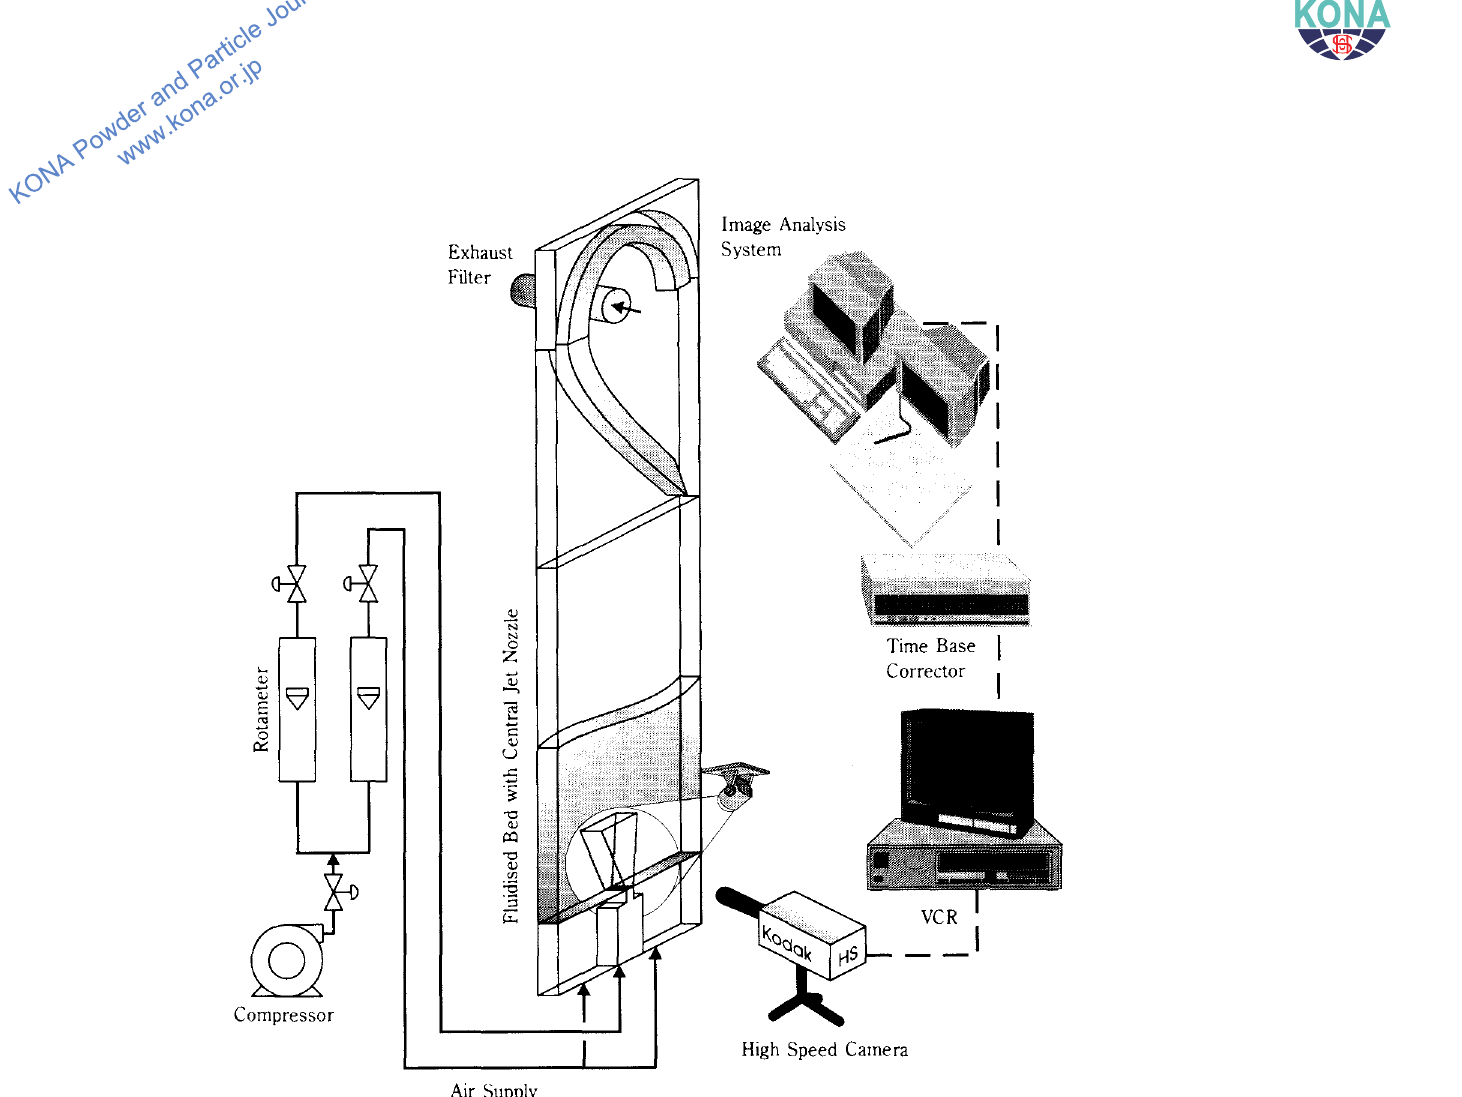
Fig. 5 Two-dimensional fluidised bed for high-speed video imaging of